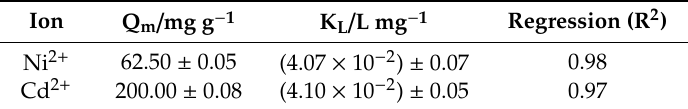
Table 6. Separation factors (R L ) at each adsorbate concentration.